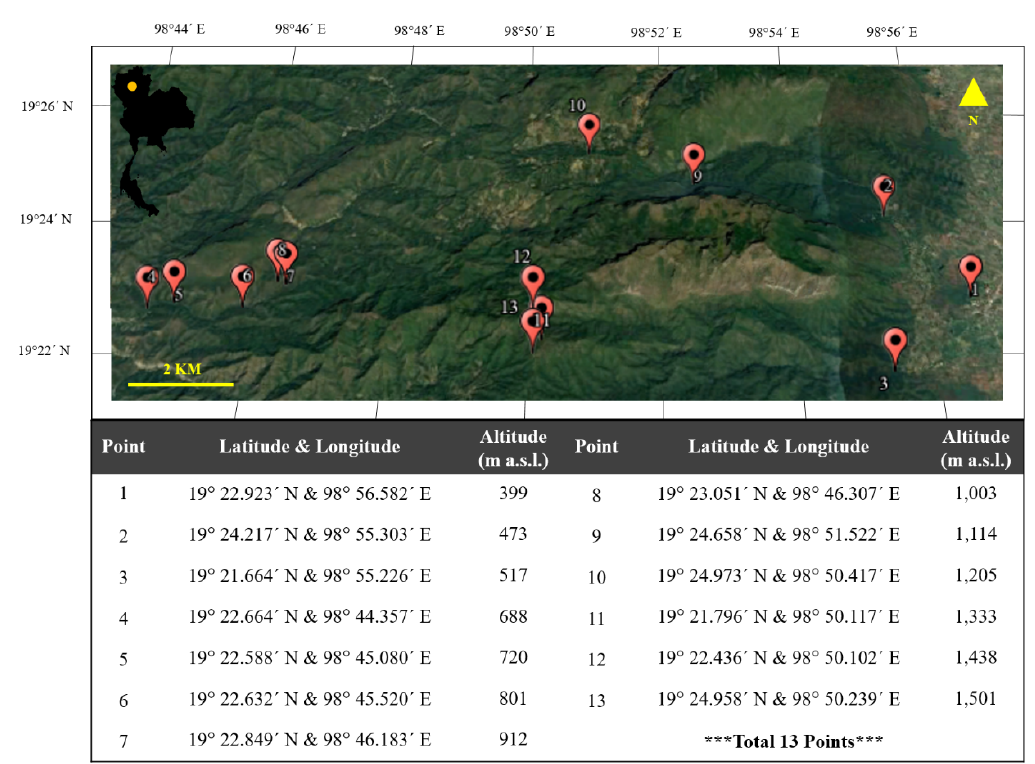
Figure 1 Map modified from Google Earth of the 13 sampling points with geographical locations (coordinates) and altitudes marked using the Garmin eTrex 30x handheld GPS unit in Chiang Dao Wildlife Sanctuary, Chiang Mai